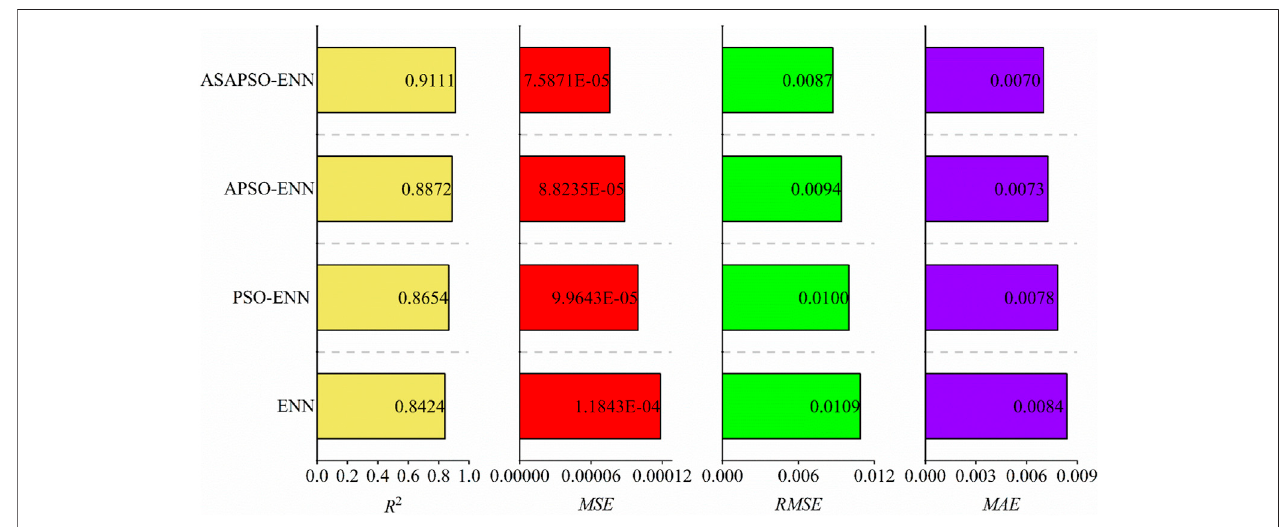
FIGURE 11 | Comparison of error evaluation indicators of different evaluation models.